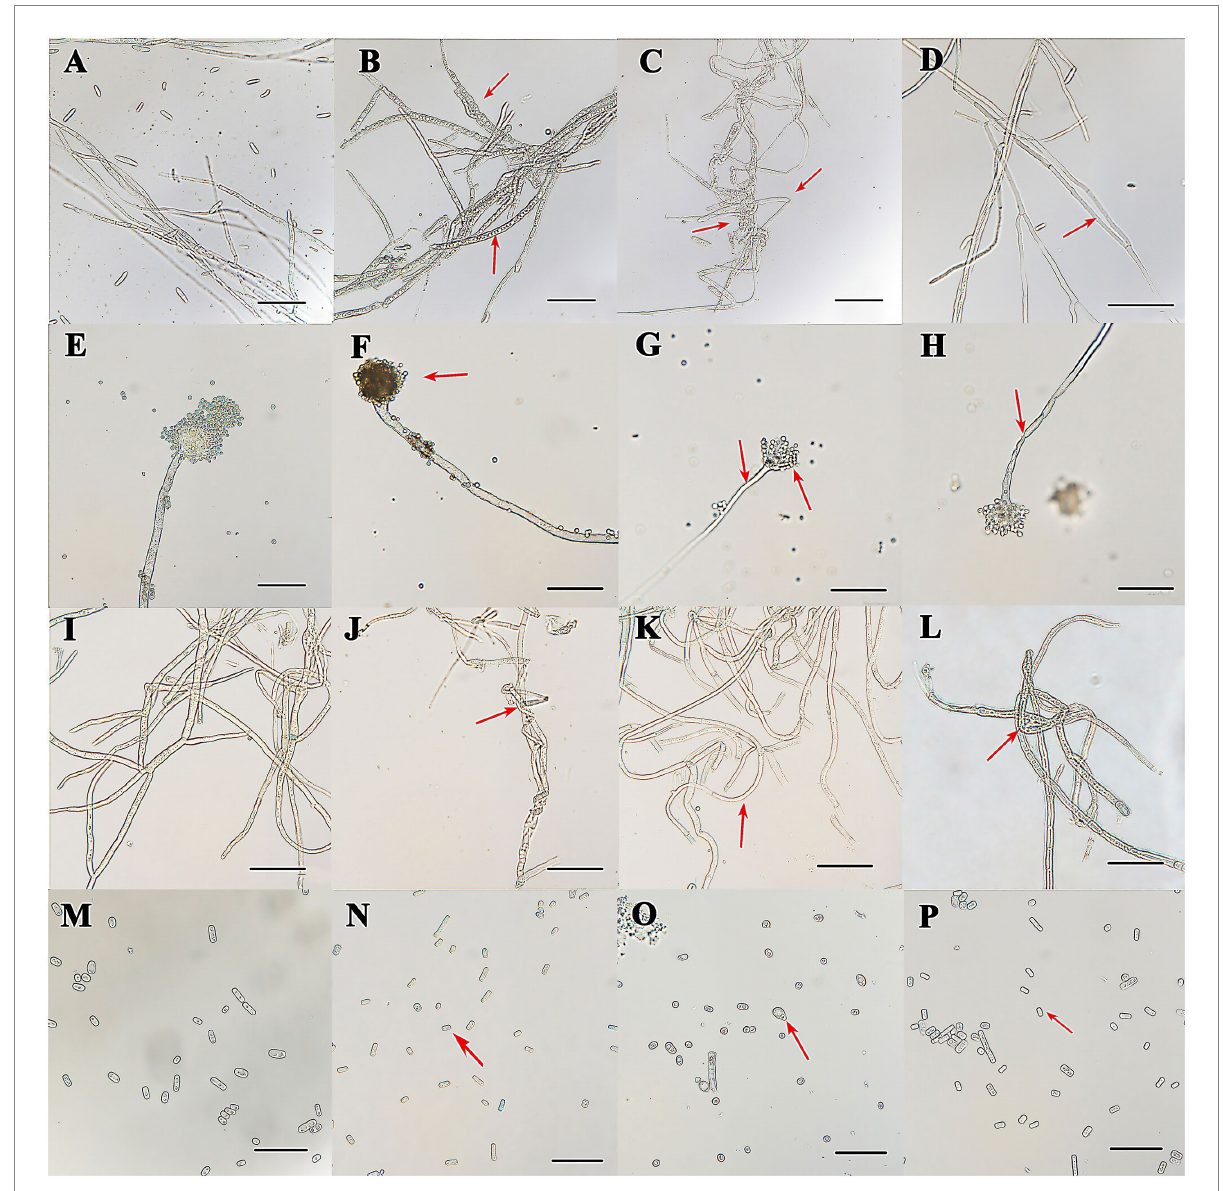
fimbriata . (G,H) was mycelia collapsed and conidia reduced treated with compounds Benzaldehyde and 2-Phenylethanol in A. flavus. (J,L) were curling or twisted in B. cinerea mycelium treated with C. fimbriata strain and 2-Phenylethanol. (K) The transverse septae disappeared